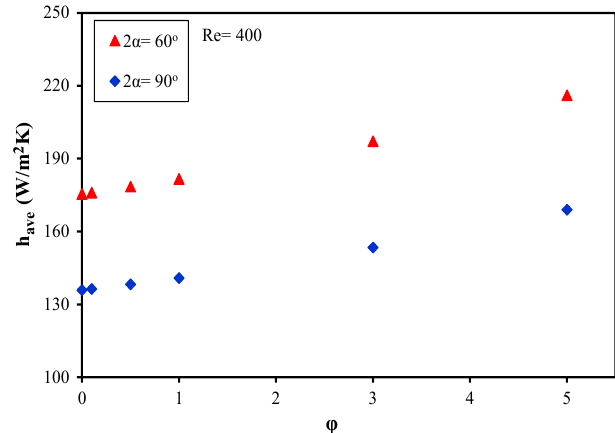
Fig. 5. Average heat transfer coefficient of nanofluids vs. Pe for different values of channel apex angle and different nanoparticle concentrations.